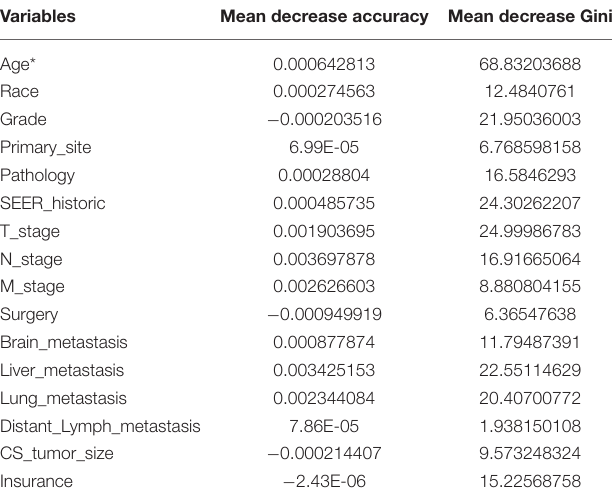
TABLE 3 | The candidate variables screening associated with bone metastasis based on random forest model.